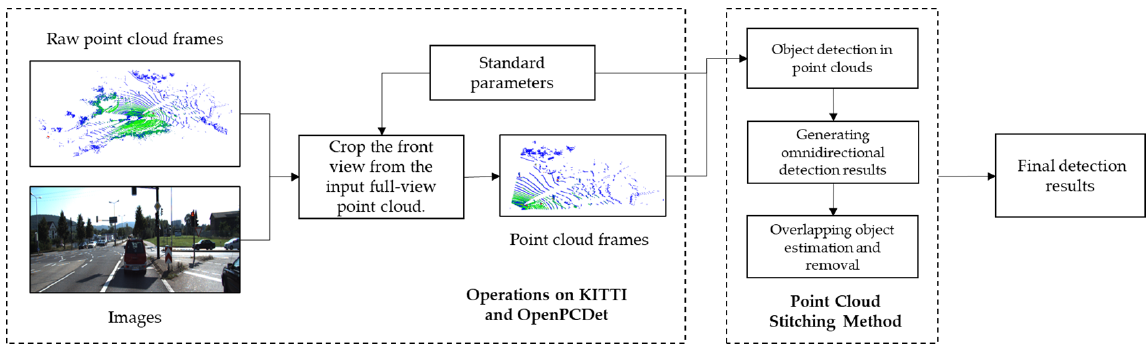
Figure 1. The framework of the proposed s titching method.